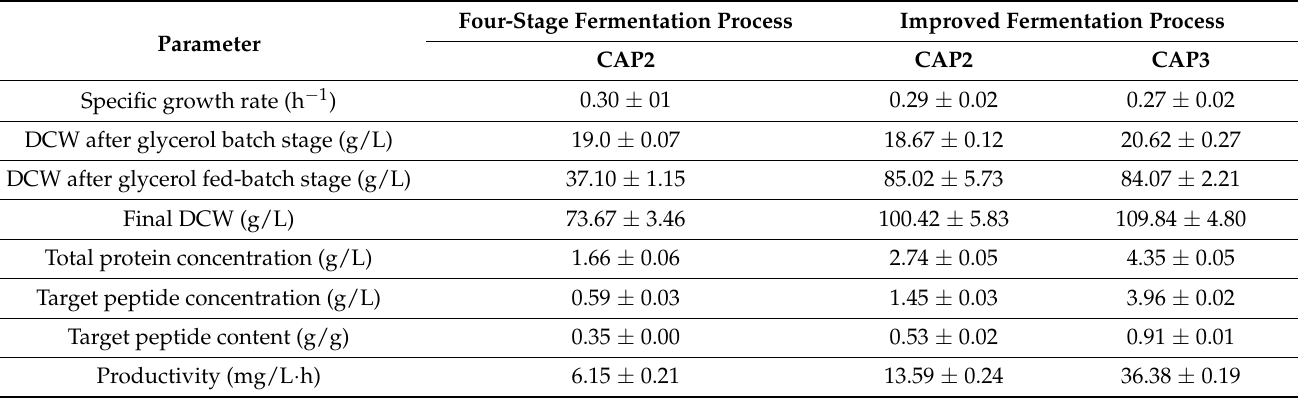
Table 1. Comparison of the fermentation parameters between the four-stage fermentation process and the improved fermentation